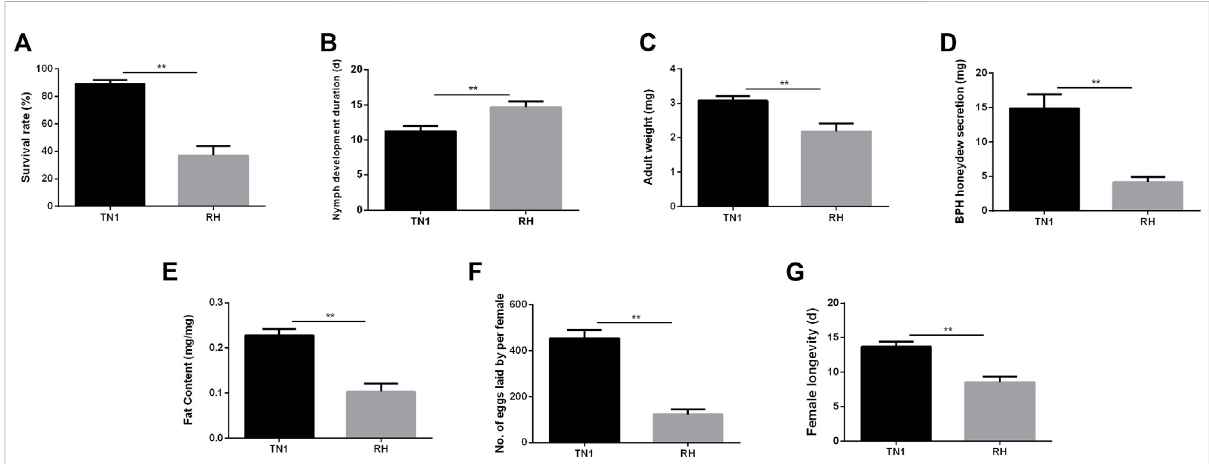
FIGURE 1 The ecological fi tness of the brown planthopper (BPH), Nilaparvata lugens that fed on different rice varieties. (A) Survival rate. (B) Nymph development duration. (C) Female adult weight. (D) BPH honeydew secretion. (E) Fat content. (F) Number of eggs laid per female. (G) Female longevity. (A – G) were repeated for 20, 60, 6, and 15 times, respectively. The values are presented as the mean ± SEM. Asterisks indicate signi fi cant differences revealed by Student ’ s t test, at * p < 0.05 and ** p < 0.01,